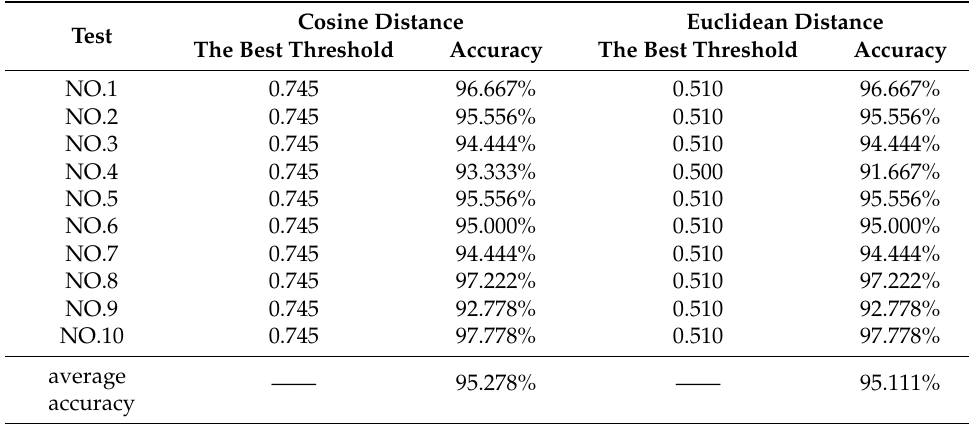
Figure 9. Examples of positive and negative sample pairs that identified errors. Table 6. Results of the ten-fold cross-validation test of the optimal